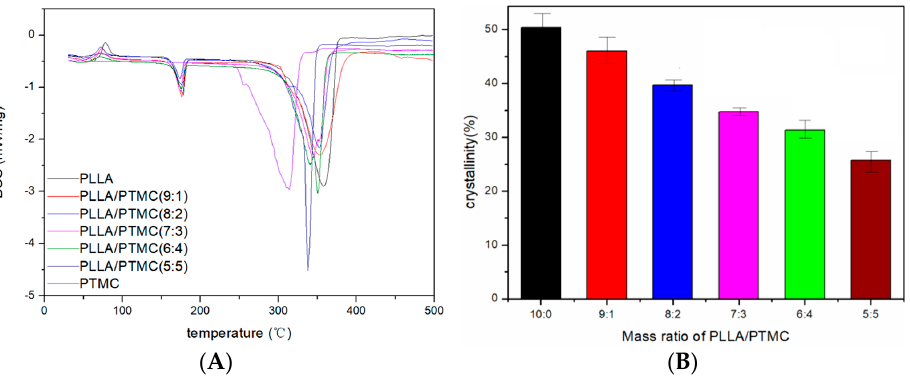
Figure 3. Differential scanning calorimetry curves ( A ) and crystallinity ( B ) of PLLA/PTMC electrospun fibres. p < 0.05; error bars indicate SD; n = 3.